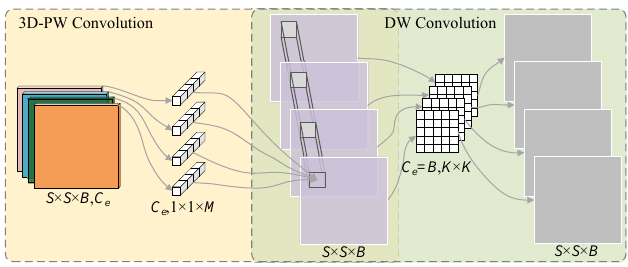
Figure 3. Schematic illustration of lightweight 3D spectral–spatial feature learning with two parts: 3D-PW and DW